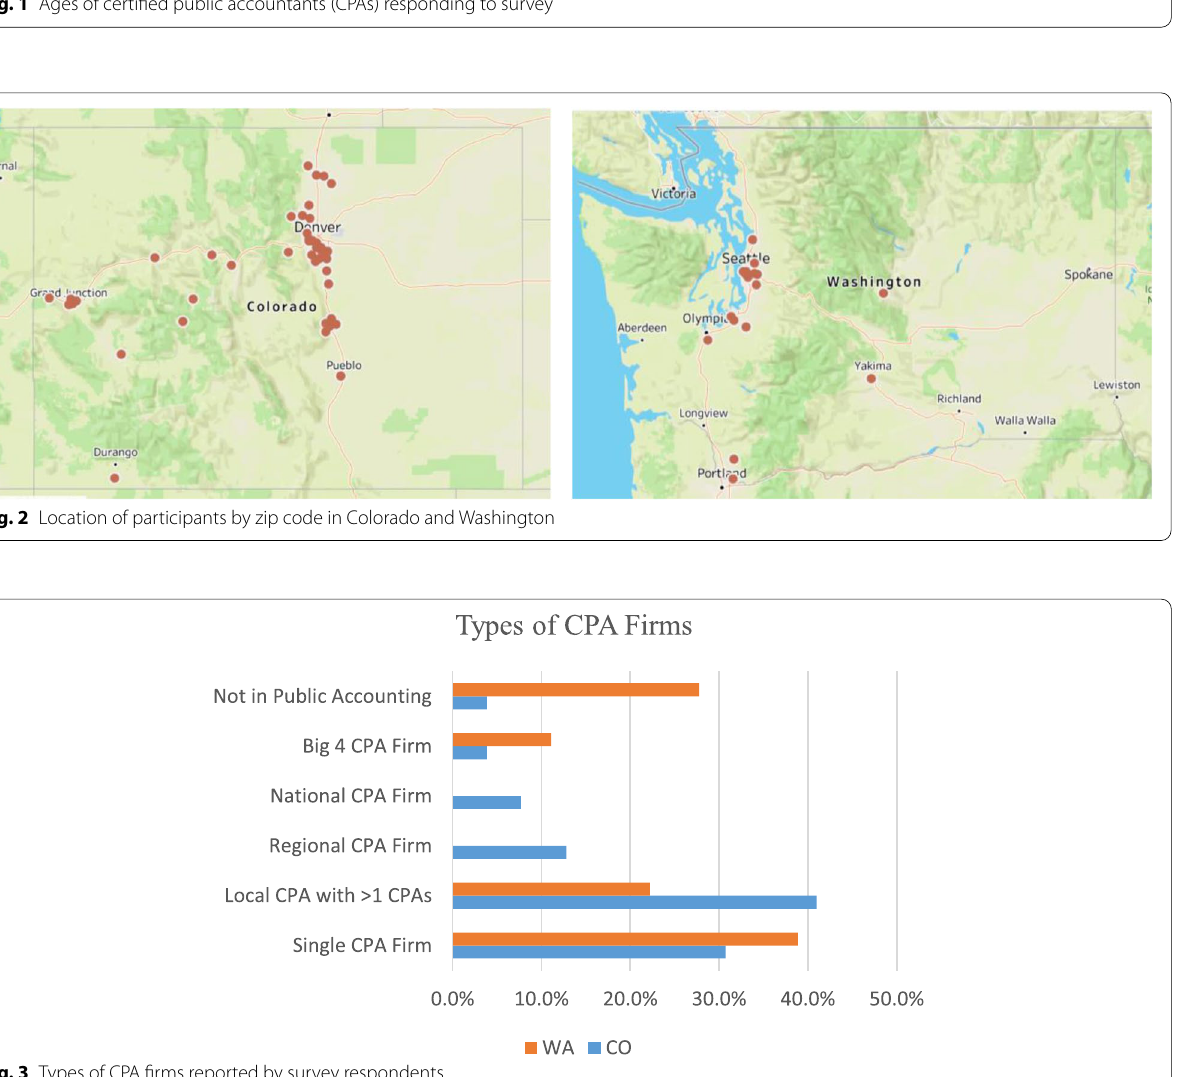
Fig. 1 Ages of certified public accountants (CPAs) responding to survey